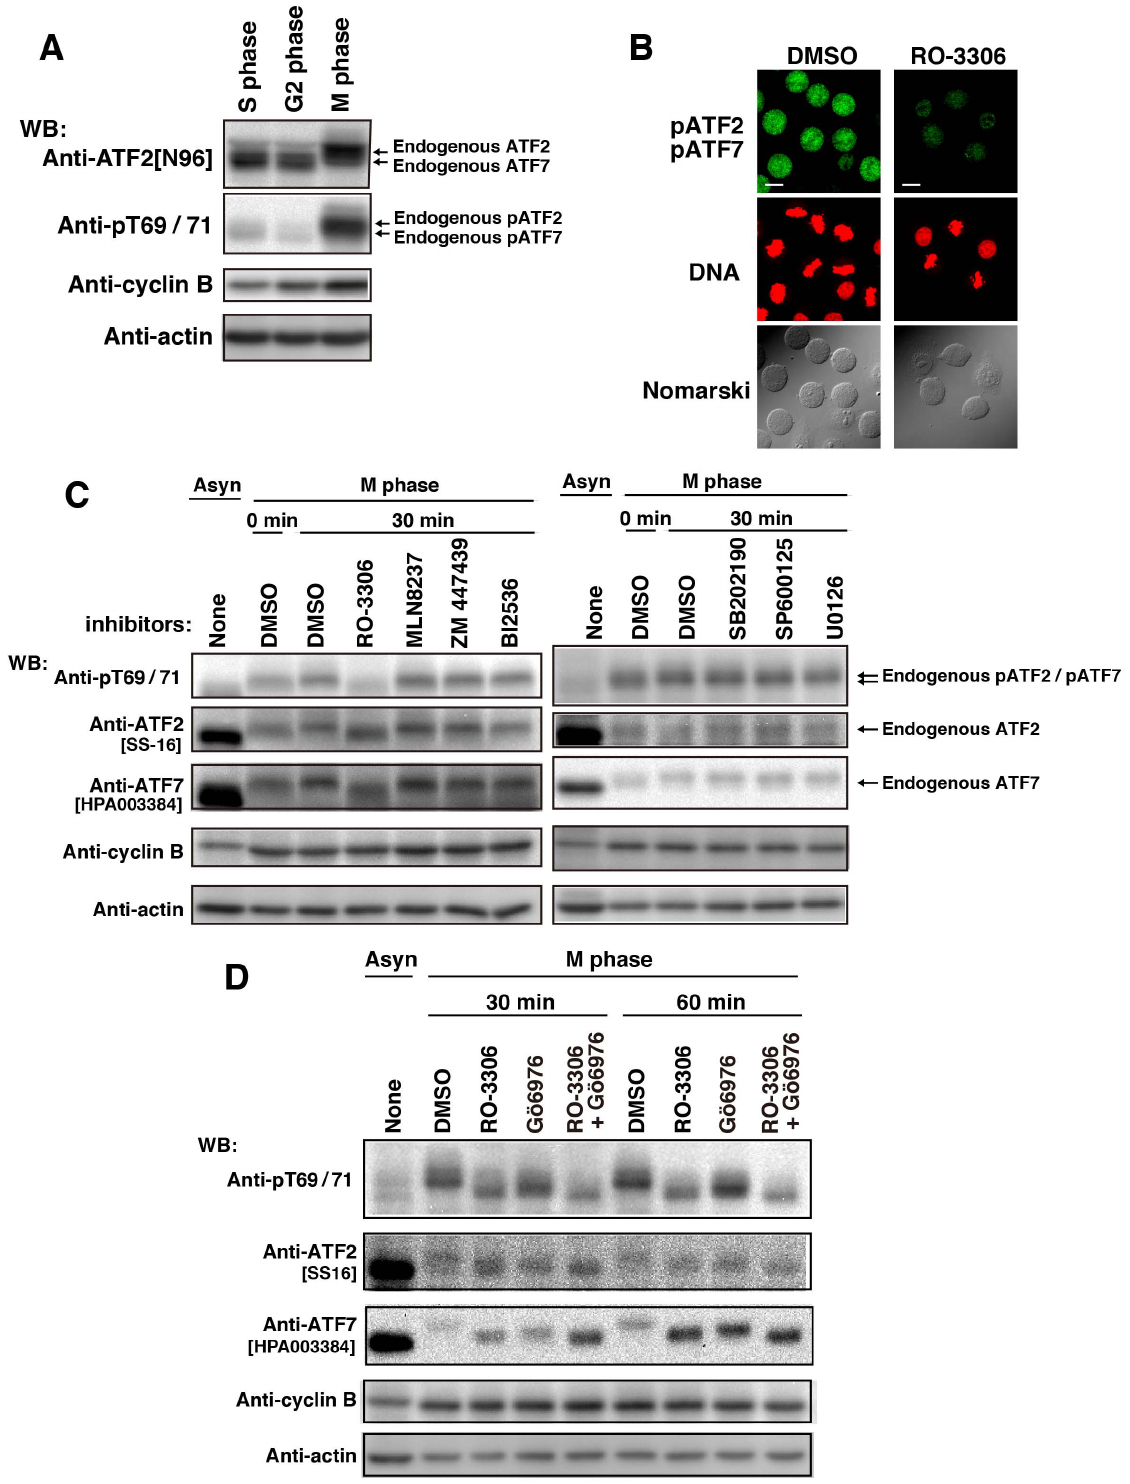
Fig. 2. Mitotic phosphorylation of ATF2 and ATF7 by Cdk1. ( A ) Cells were synchronized at S, G2, or M phases. Mitotic cells were collected by mitotic shake-off, and whole cell lysates were analyzed by WB using antibodies against ATF2/ATF7 (ATF2[N96]), pATF2/pATF7 (pT69/71), cyclin B1, and actin. ( B–